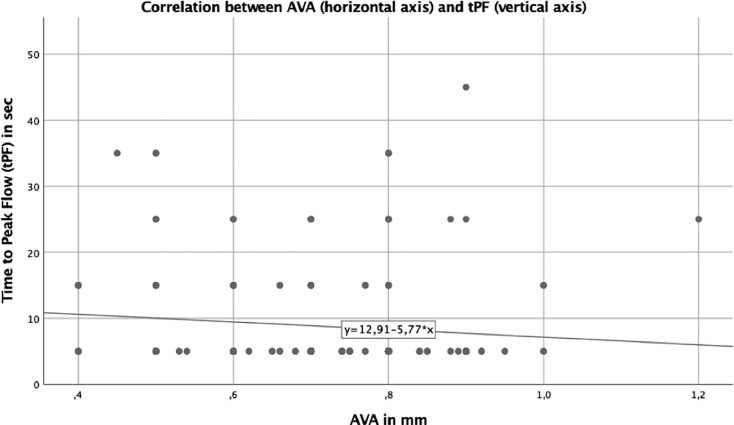
Correlation between AVA and tPF in patients with AS.The scatter plot shows a positive trend between AVA reduction and prolonged tPF in patients with AS.